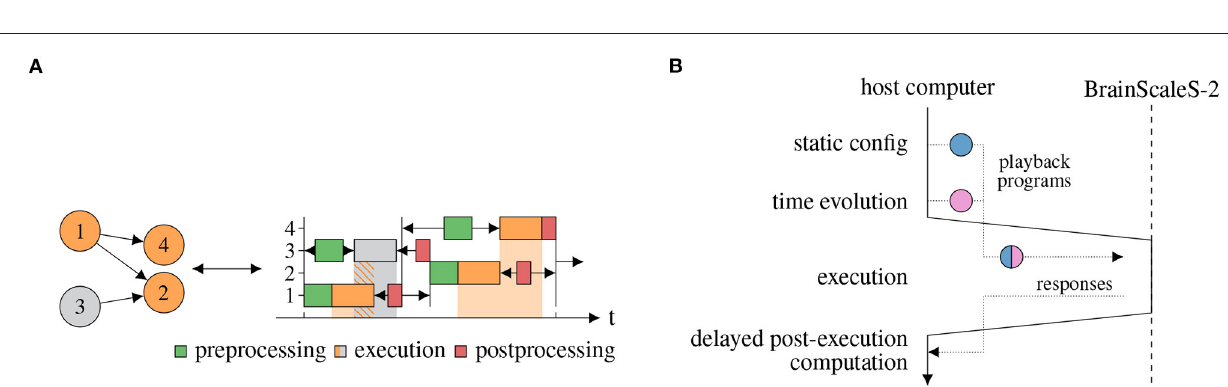
FIGURE 4 | Signal-flow graph-based experiment abstraction on BSS-2. (A) Placed feed-forward network represented as signal-flow graph. (Left) Abstract network; (Middle) Actual layout on the chip, the arrows represent the graph edges; (Right) The network graph structure enlarged with signal type annotation on the edges. The color links the same entities in the middle (chip schematic) and right subfigure (vertical data-flow graph). (B) Non-spiking network distributed over two physical chips, adapted from Spilger et al. (2020). The result of two matrix multiplications on chips 1 and 2 is added on chip 1. The latter execution instance depends on the output of the two former instances.